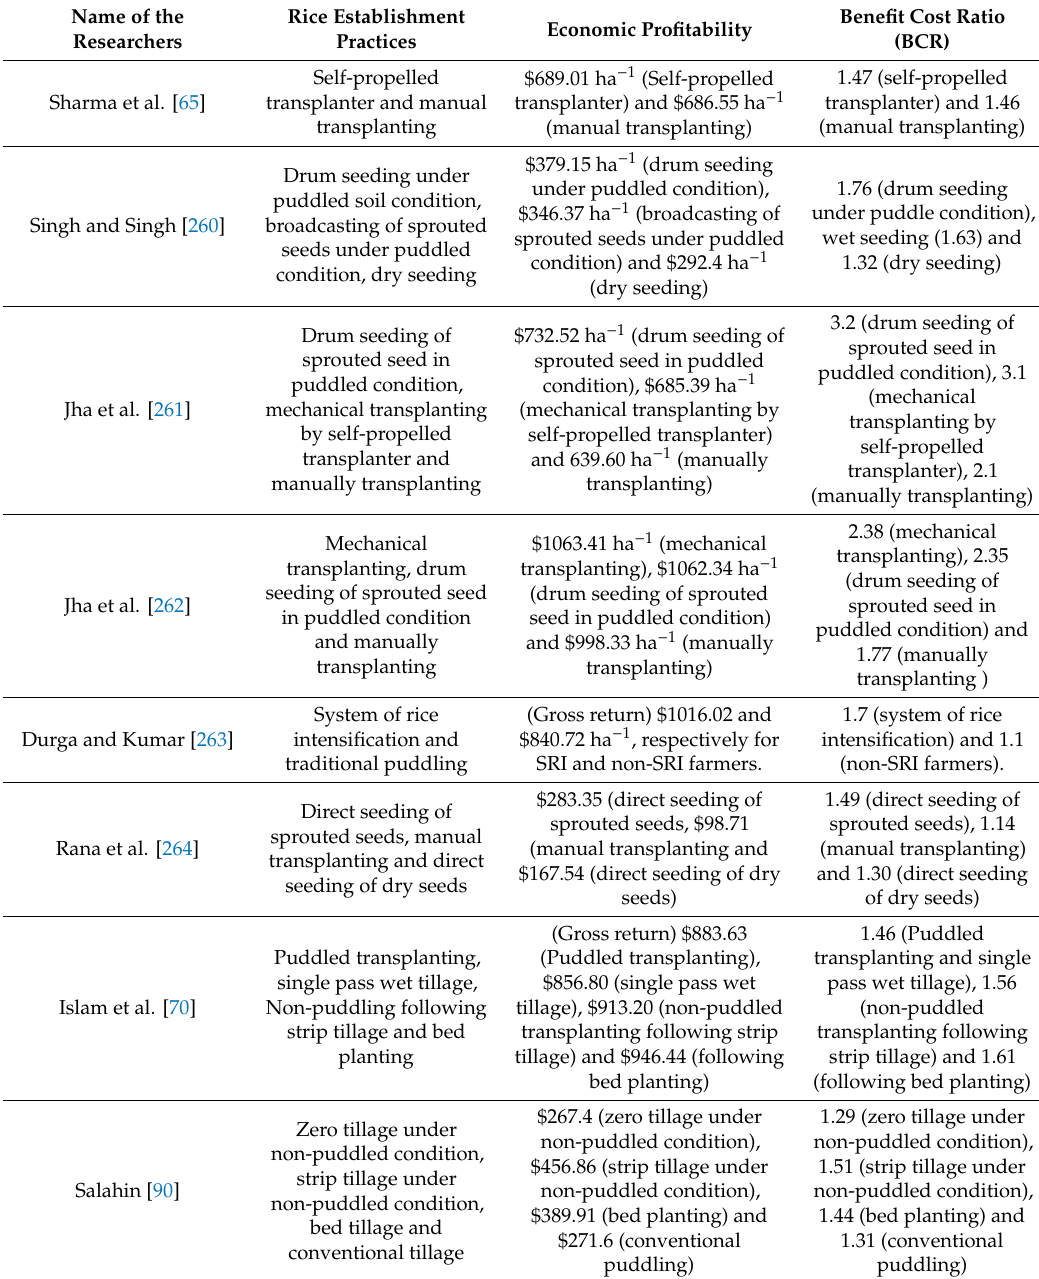
Table 2. Economics of rice crop establishment